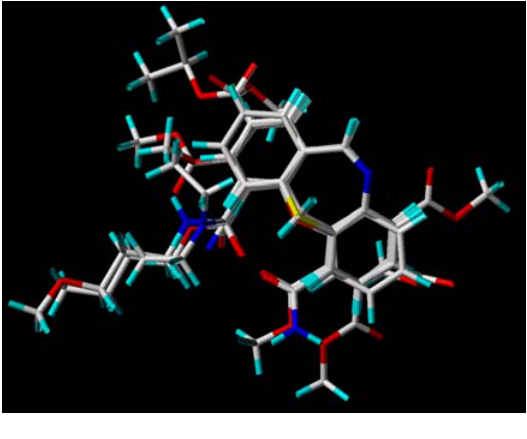
Figure 12. Alignment of the compounds used in the training